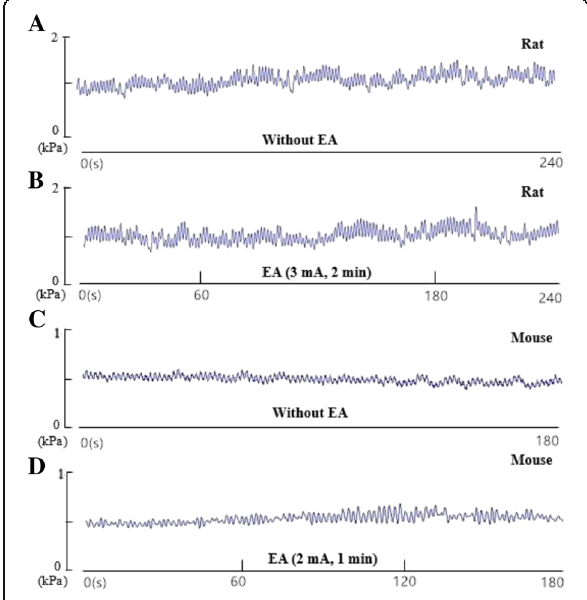
Fig. 2 Changes in jejunal motility without or with EA at LI11. a A representative tracing of jejunal motility in a rat without any treatment. b A representative tracing of jejunal motility enhanced by EA at LI11 in a rat. c A representative tracing of jejunal motility in a mouse without any treatment. d A representative tracing of jejunal motility enhanced by EA at LI11 in a mouse. EA,